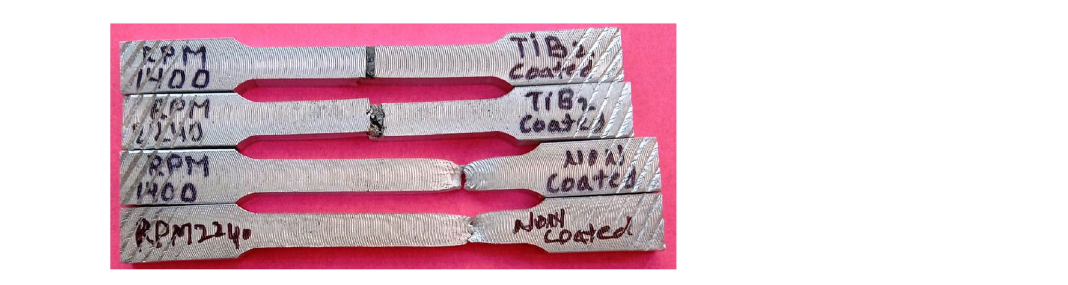
Figure 11. Tensile tested samples.